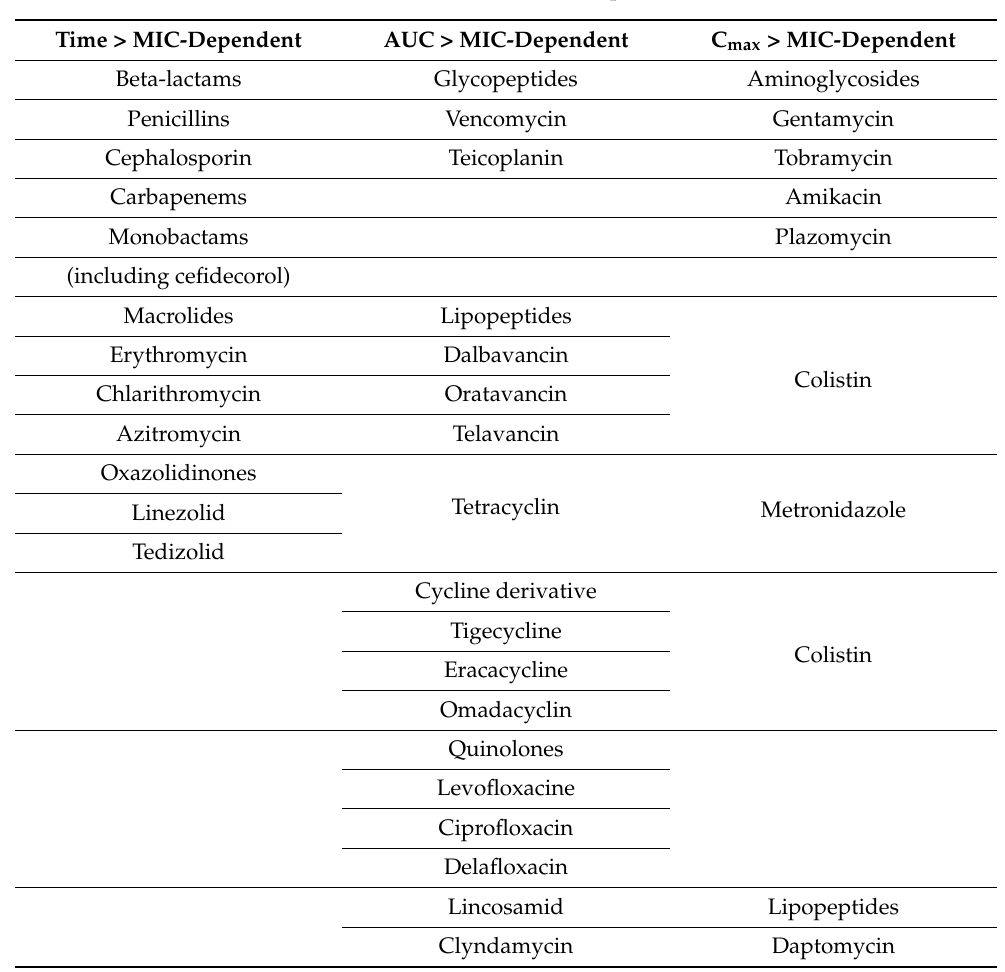
Table 2. Most-used and -studied time- and concentration-dependent antibiotics.